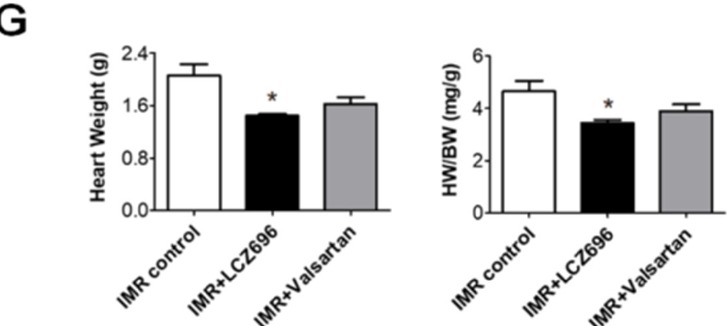
Figure 2. ( A ) Comparison of serial changes in end-diastolic volume (EDV) of the left ventricle until 6 weeks after myocardial infarction (MI) among the three groups. ( B ) Quantitative graphs of cardiac magnetic resonance imaging (MRI) measurements, which showed that EDV was significantly lower in the LCZ696 group than in the control group. There were no significant differences between the valsartan group and the control group. ( C ) Comparison of representative M-mode images acquired by echocardiogram at 6 weeks after MI from the three groups. Scale bar = 5 mm. ( D ) Quantitative graphs of echocardiographic measurements, which showed that end-diastolic dimensions were also significantly lower in the LCZ696 group than in the control group. ( E ) Representative images of cardiac MRI at baseline and 6 weeks after MI and immunohistochemistry at 6 weeks from the three groups. Scale bar = 3 mm. ( F ) A quantitative graph, which shows that the extent of myocardial fibrosis was smaller in the LCZ696 group than in the control group. LV PSR means overall fibrotic area of LV myocardium regardless of infarct size. ( G ) The LCZ696 group also had significantly lower heart weight than the control group, while valsartan did not. EDV indicates end-diastolic volume; IMR, ischemic mitral regurgitation; EF, ejection fraction; LV, left ventricle; EDD, end-diastolic dimension; wk, week; MI, myocardial infarction; H&E, Hematoxylin and eosin stain; PSR, picrosirius red stain; HW, heart weight; BW, body weight. * p < 0.05 for differences from the control group.